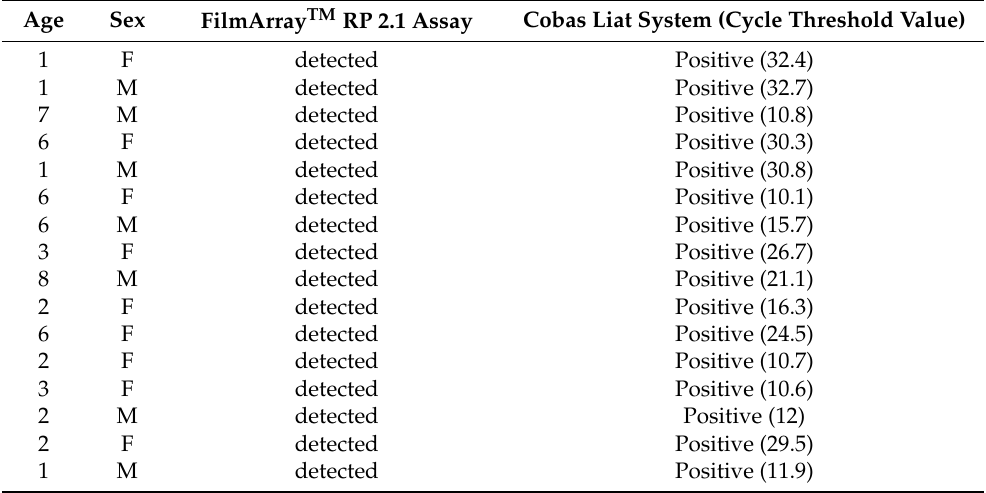
Table 2. Detection of SARS-CoV-2 from nasopharyngeal swab (NPS) specimens using the FilmArray TM RP 2.1 assay and cobas Liat